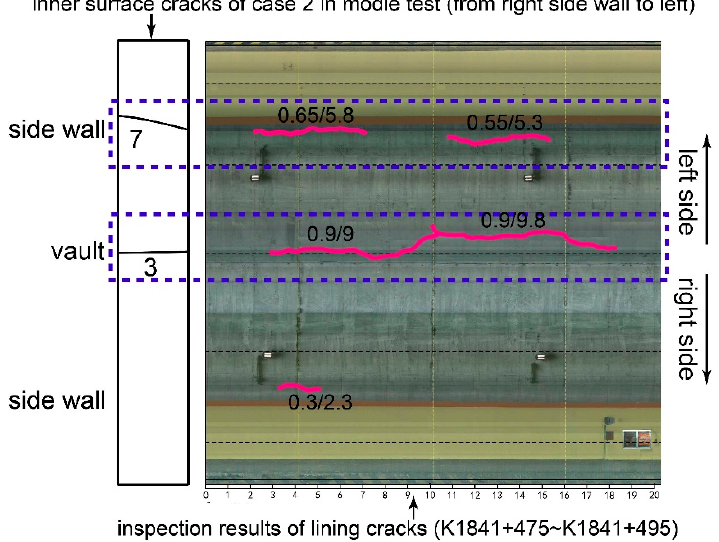
Figure 19. Comparison of inner surface cracks between test results of case 3 and lining inspection results in sections K1841 + 475~K1841 + 495.